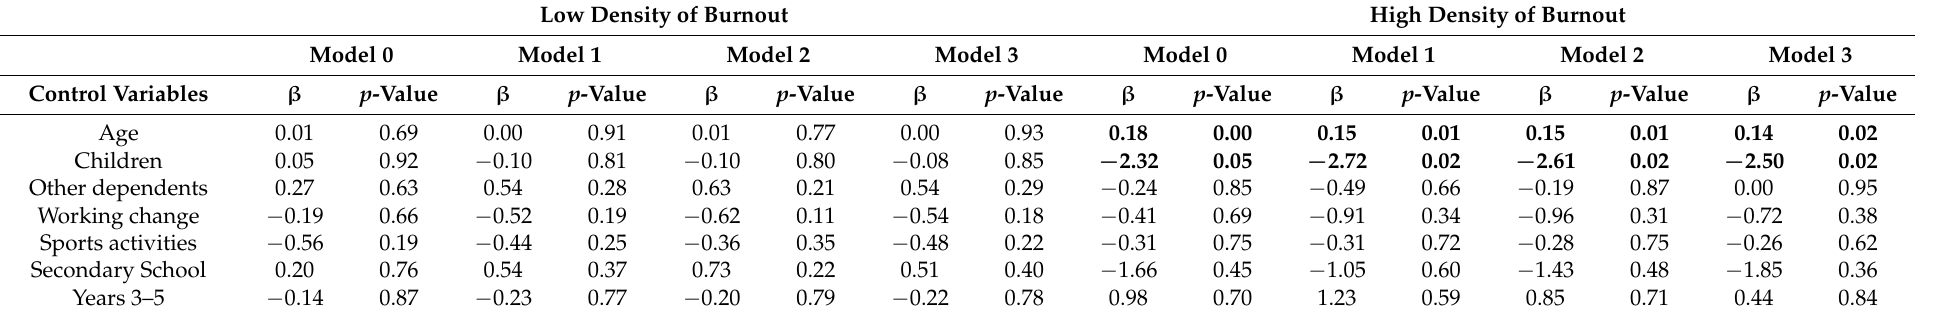
Table 4. Regression models for the density of stress (frequency X severity) in low burnout and high burnout